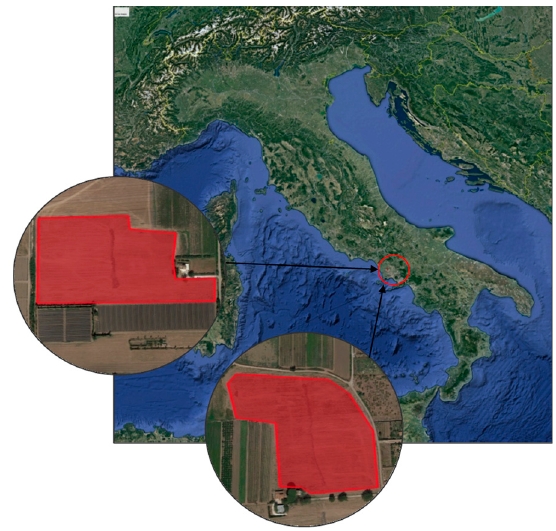
Figure 1. Localization of the pilot area and the two experimental fields.